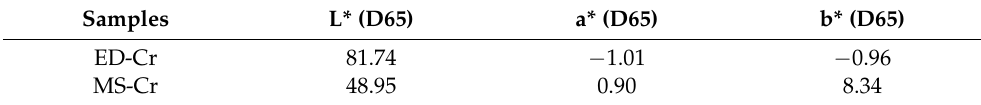
Table 1. Color parameters characteristic of ED and MS chromium coatings.